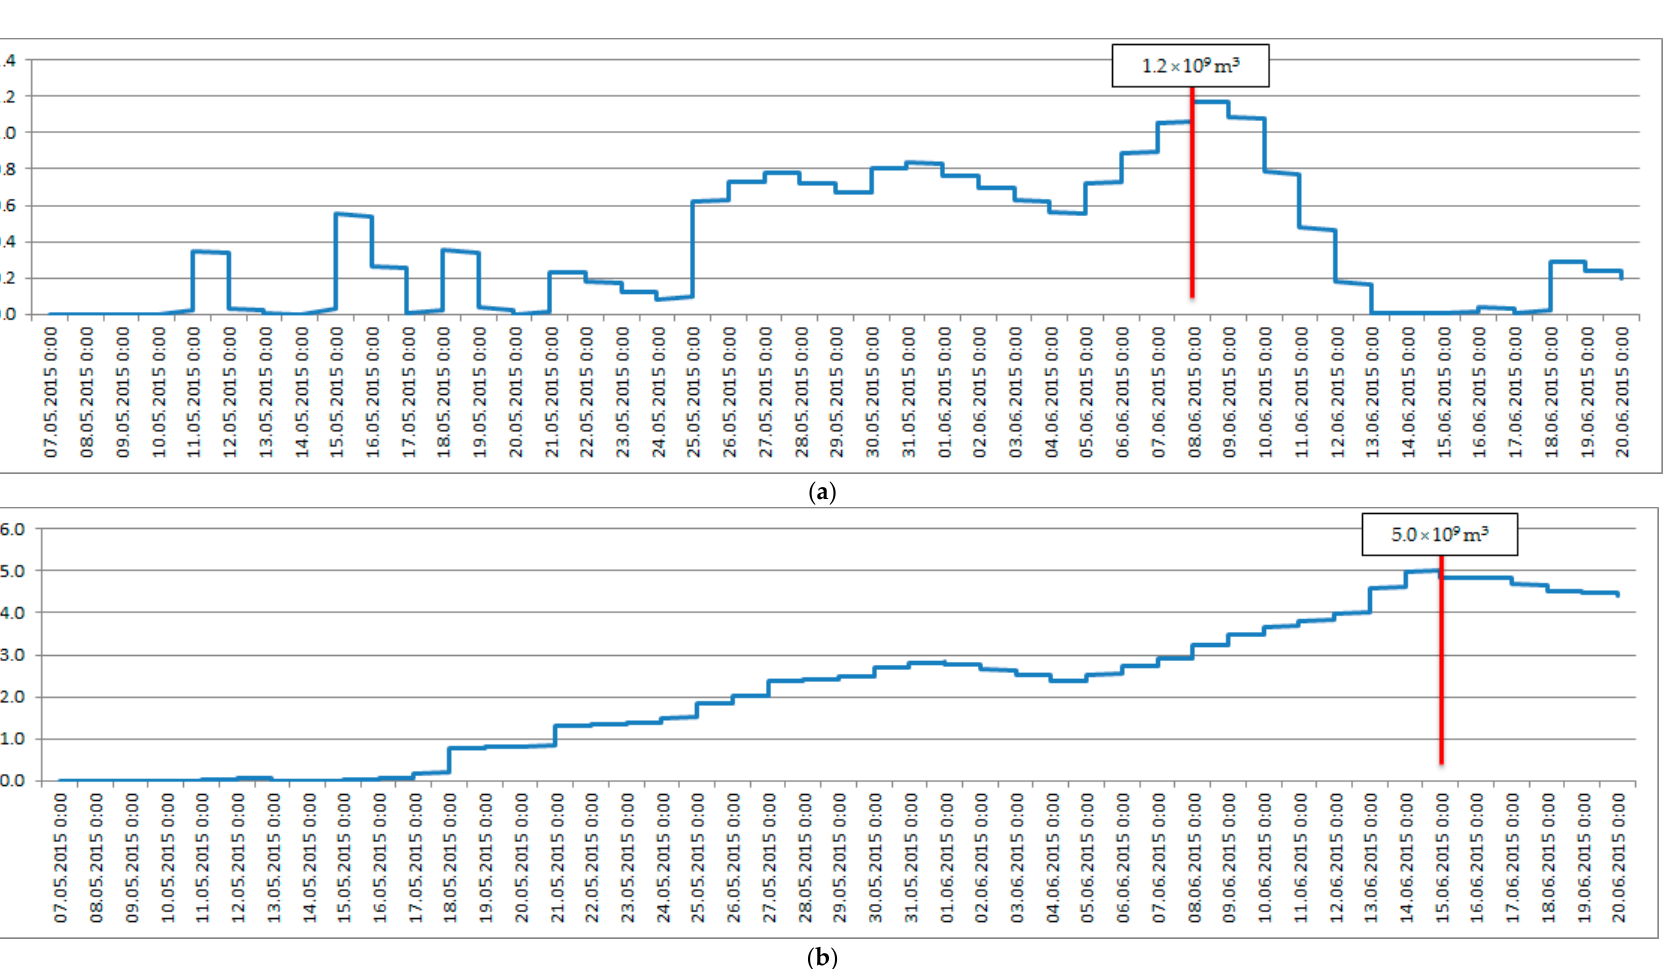
Figure 3. Accumulated water mass in the regions of: ( a ) Shreveport; ( b ) Alexandria.